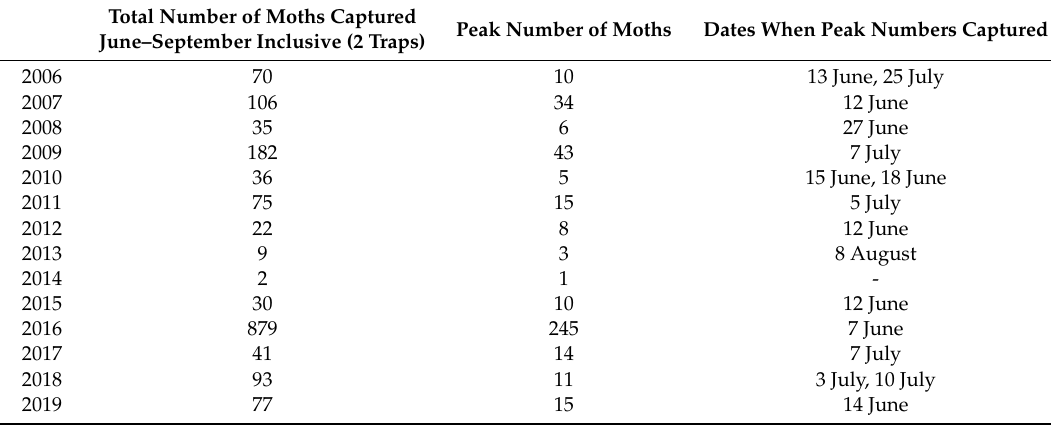
Table 2. Captures of male P. xylostella in two pheromone traps at Wellesbourne in Warwickshire 2006–2019.